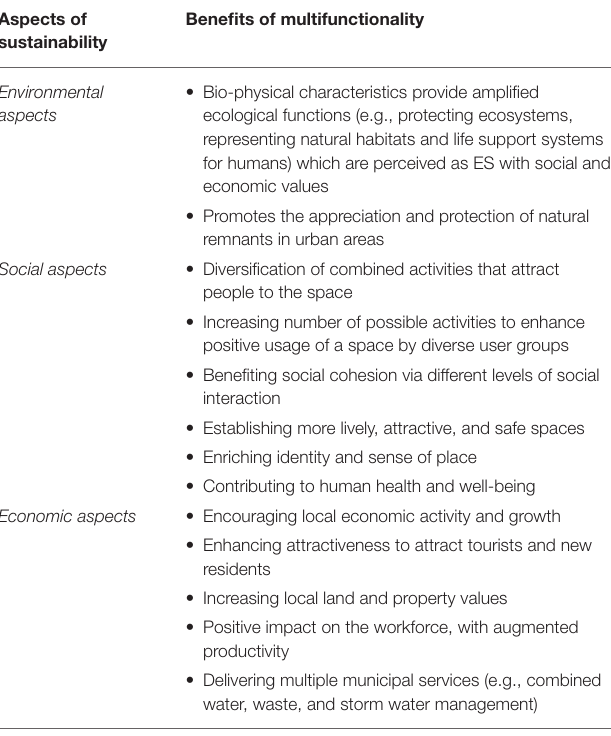
TABLE 2 | Summary of the benefits of multifunctionality in relation to the aspects of